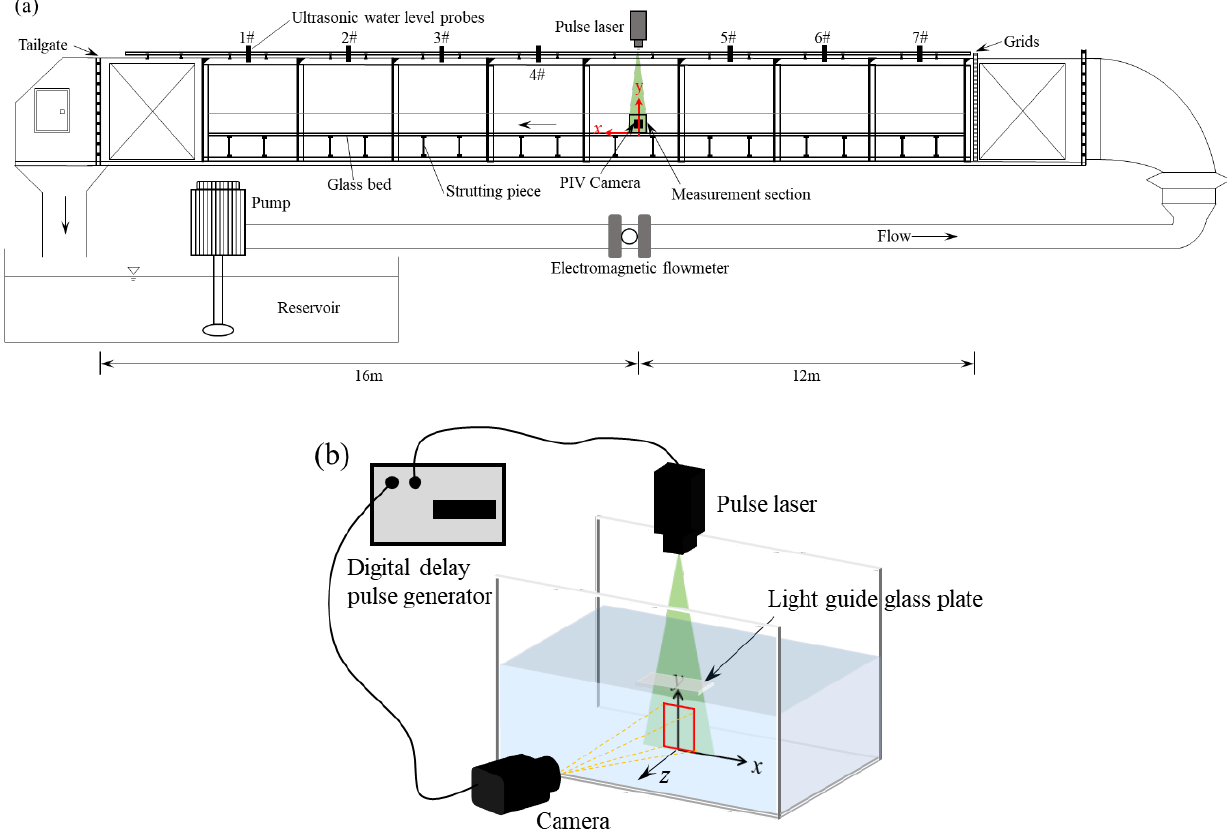
Figure 1. ( a ) Schematic of an open-channel flume (not to scale) and ( b ) PIV system arrangement (a small light guided glass plate (10 cm long, 5 cm wide and 0.2 cm thick) is arranged right above the water surface to eliminate the surface fluctuations).